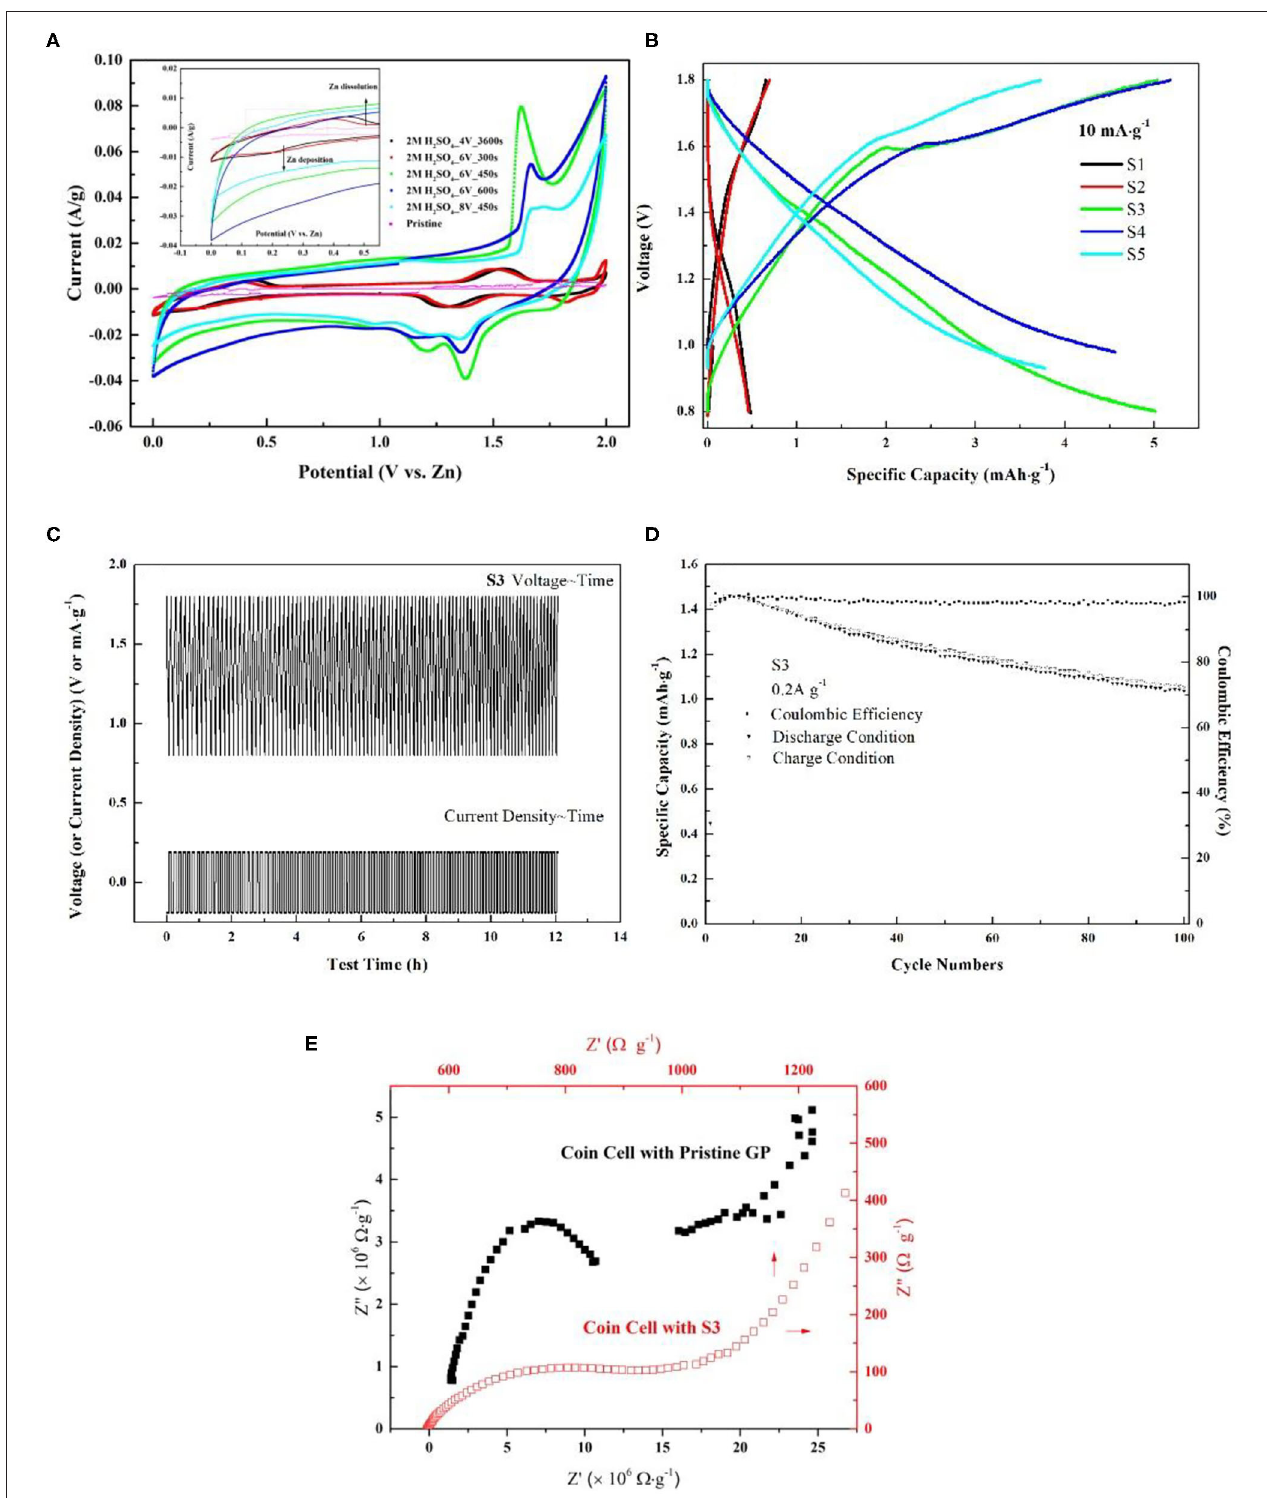
FIGURE 5 | (A) Cyclic voltammetry comparison among pristine GP, S1, S2, S3, S4, and S5. The measurement was conducted by using CR2032 coin-type cell with Zn foil as counter electrode and 1M ZnSO 4 as electrolyte. The scan rate was 1mV s − 1 ; (B) Galvanostatic charge/discharge curves of AGP/Zn between 0.8 and 1.9V at 10mA g − 1 ; (C) Gavanostatic cycling of S3 at 0.2A g − 1 for 100 cycles; (D) Cycling performance of the cell with S3 as cathode at 0.2A g − 1 ; (E) EIS Nyquist plots comparison between coin cell with pristine GP and S3. The data was captured under their respective open circuit potential.